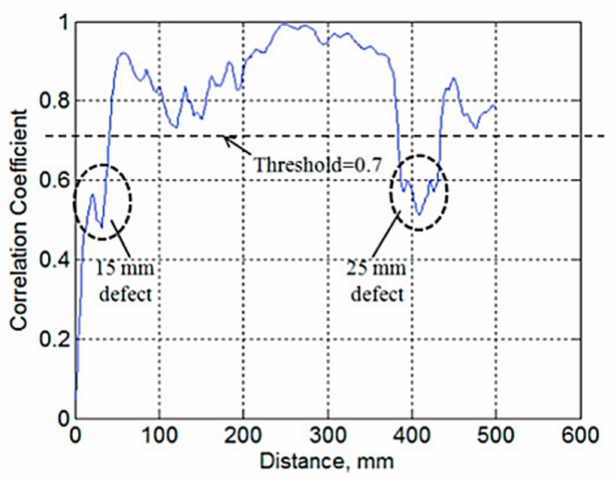
Figure 16. Correlation coefficient along with the scanning onto the materials using cross-correlation [75].